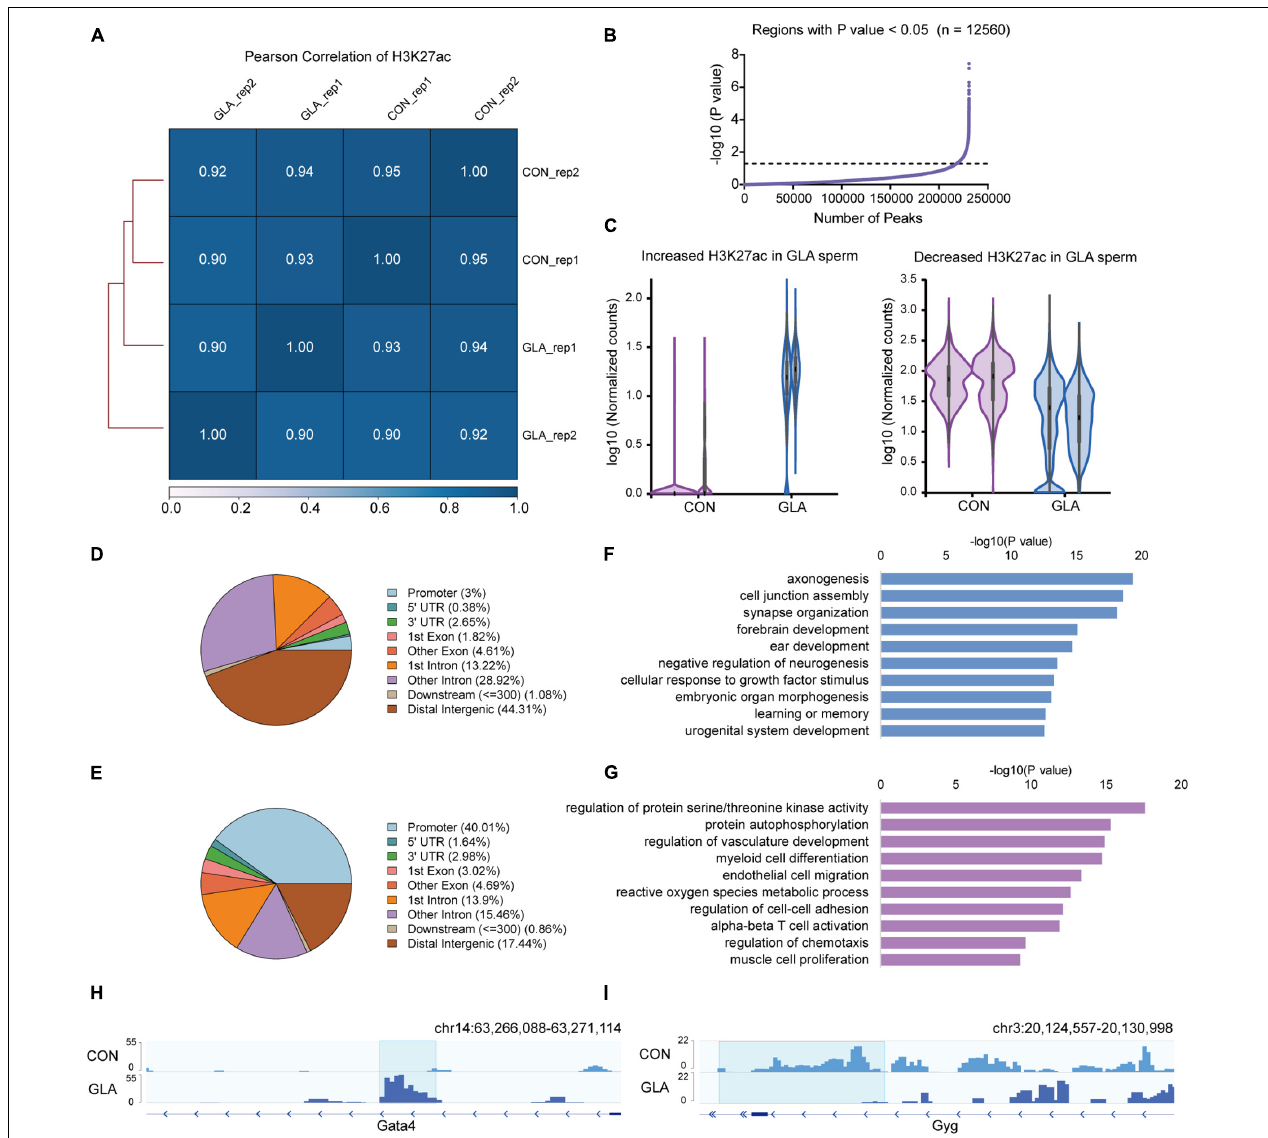
FIGURE 3 | GLA-induced H3K27ac alterations in mouse sperm. (A) Correlation matrix showing Pearson correlation coefficient of H3K27ac between replicates of CON and GLA sperm. (B) Selection of regions with P -value < 0.05. The black dashed line corresponds to the boundary of P -value = 0.05. (C) Violin plots showing increased and decreased H3K27ac in GLA sperm. Two replicates in each group are in the same color. (D,E) Pie chart showing the genomic distribution of regions with increased (D) and decreased (E) H3K27ac signals in GLA sperm. (F,G) Selected significant pathways from Gene Ontology analysis on genes with increased (F) or decreased (G) H3K27ac signals in GLA sperm. (H) Integrative Genomics Viewer tracks showing increased H3K27ac on Gata4 in GLA sperm. (I) Integrative Genomics Viewer tracks showing decreased H3K27ac on Gyg in GLA sperm. Blue box indicates regions with differential H3K27ac signals ( P -value <